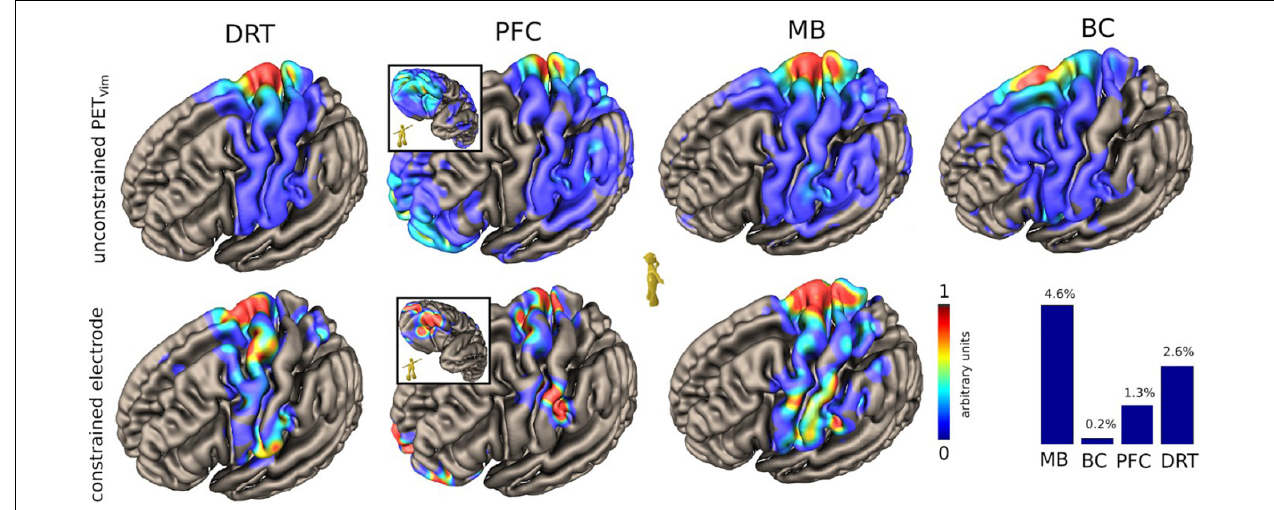
FIGURE 4 | Case #1, unconstrained and constrained cortical projection patterns of the DRT and the regarded pathways relevant for PAD (HCP group level, MNI-space). Upper panel shows cortical projection patterns constrained to thalamic (Vim) PET activation. Lower panel shows a pattern constrained to the actual volume of activated tissue of the DBS. Note how PFC and MB focus on the facial region of the sensory-motor cortex . PFC branch cortical pattern shows central and lateral orbitofrontal involvement (inset). Lateral OFC is typically involved in response inhibition (Kringelbach, 2005). The lower right histogram shows a simulated percentage of tract activation . DRT, dentato-rubro-thalamic tract; PFC, MB and BC represent branches of motorMFB with distinct regions of origin: PFC, prefrontal cortex branch; MB, mamillary body branch; BC, brainstem cerebellum branch (see also Figure 7 ).